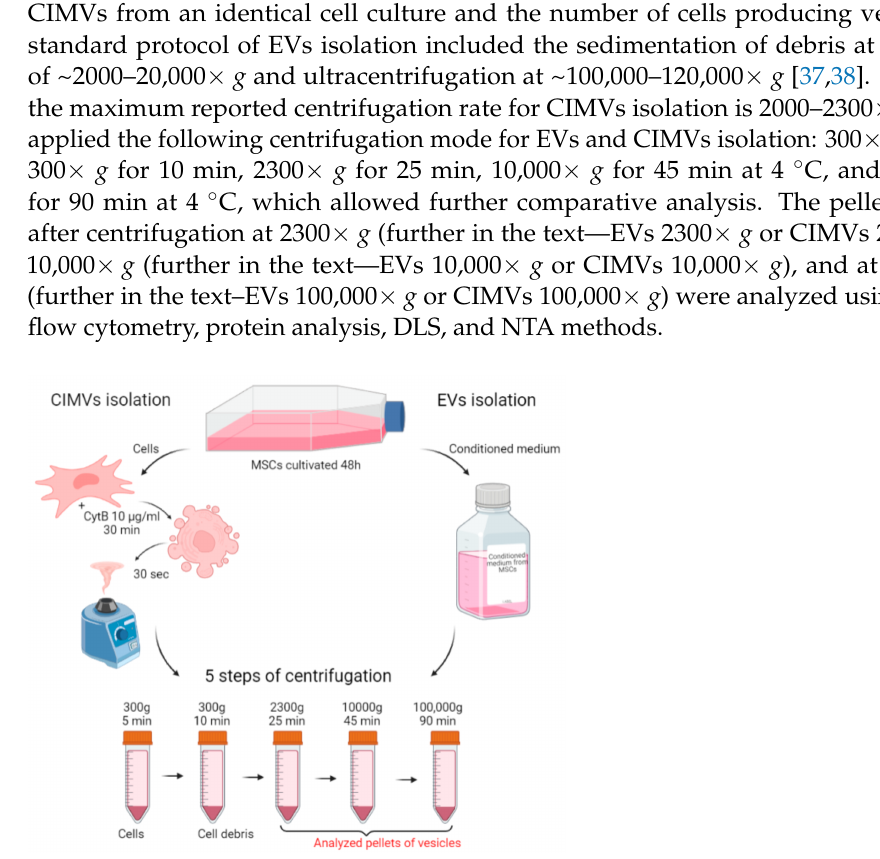
Figure 1. Scheme of the experiments. EVs and CIMVs were isolated from the same MSCs culture. Created with